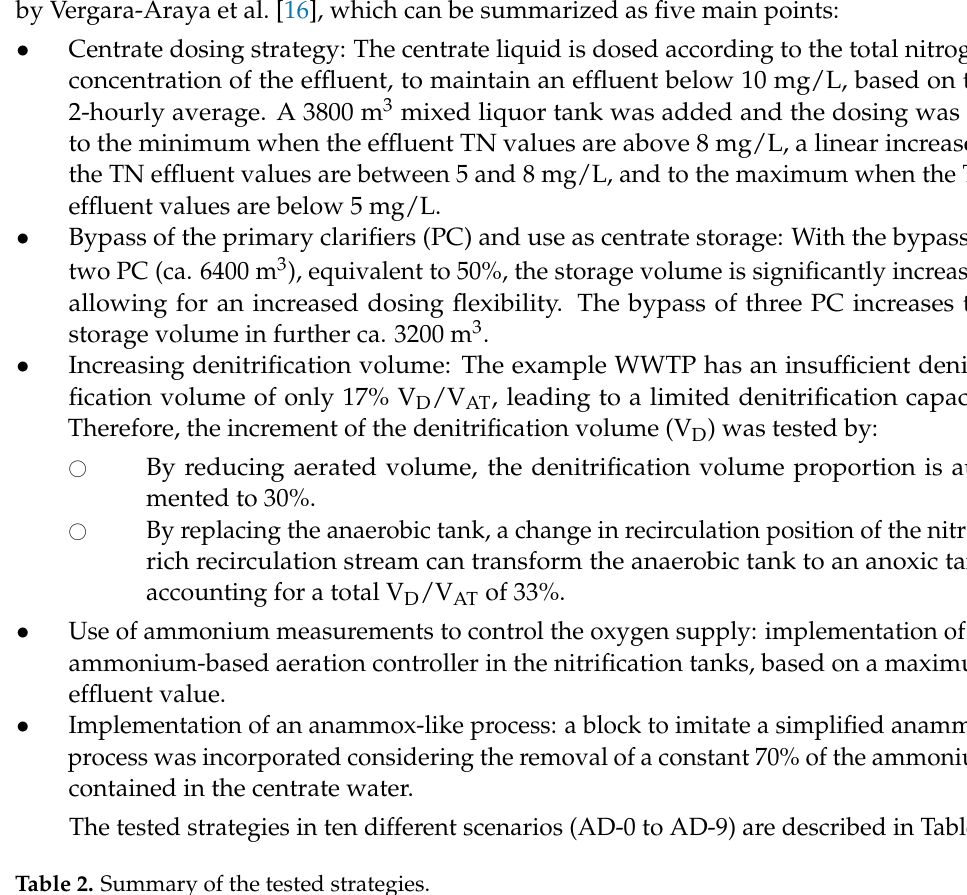
Table 2. Summary of the tested